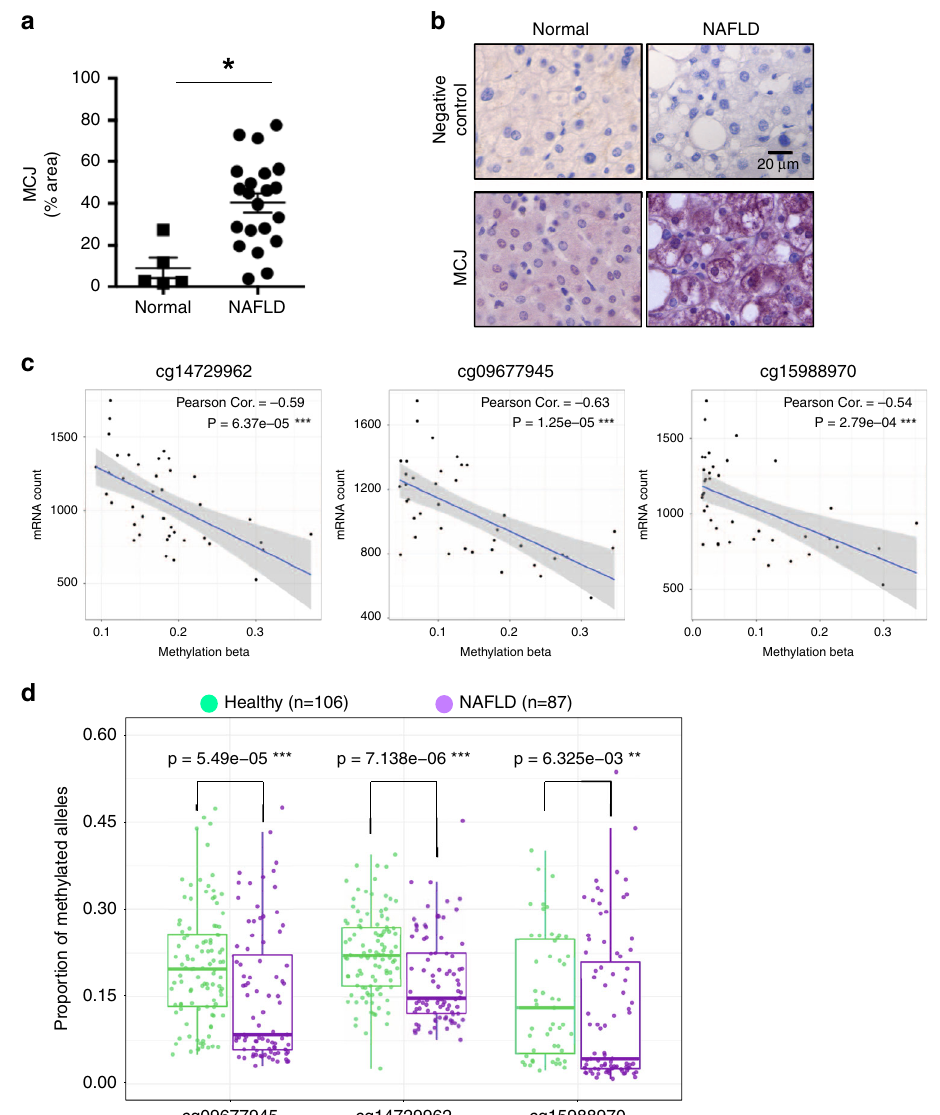
Fig. 2 Increased MCJ expression in the liver correlates with the development of NAFLD in humans. a Quanti fi cation and ( b ) representative images of liver MCJ expression determined by immunohistochemistry in human samples from healthy control subjects (Normal) ( n = 5) and patients with non- alcoholic fatty liver disease (NAFLD) ( n = 21). *denotes p < 0.05 as determined by Student ’ s t test. Error bars show standard error (SE). c Linear regression analysis for the methylation beta scores and DNAJC15 mRNA levels of the 3 CpG sites identi fi ed in Supplementary Fig 2a, b. Results show a strong negative association (all Pearson correlation coef fi cients < − 0.50 and linear regression P < 0.001). d Wilcoxon ’ s rank-sum test comparing methylation levels in NAFLD patients and healthy human liver at three gene-expression-related CpG within the DnaJC15 promoter, based on six independent GEO data sets. ** P < 0.01, *** P < 0.001. Error bars show standard error (SE) in ( a ). Source data are provided as a Source Data fi